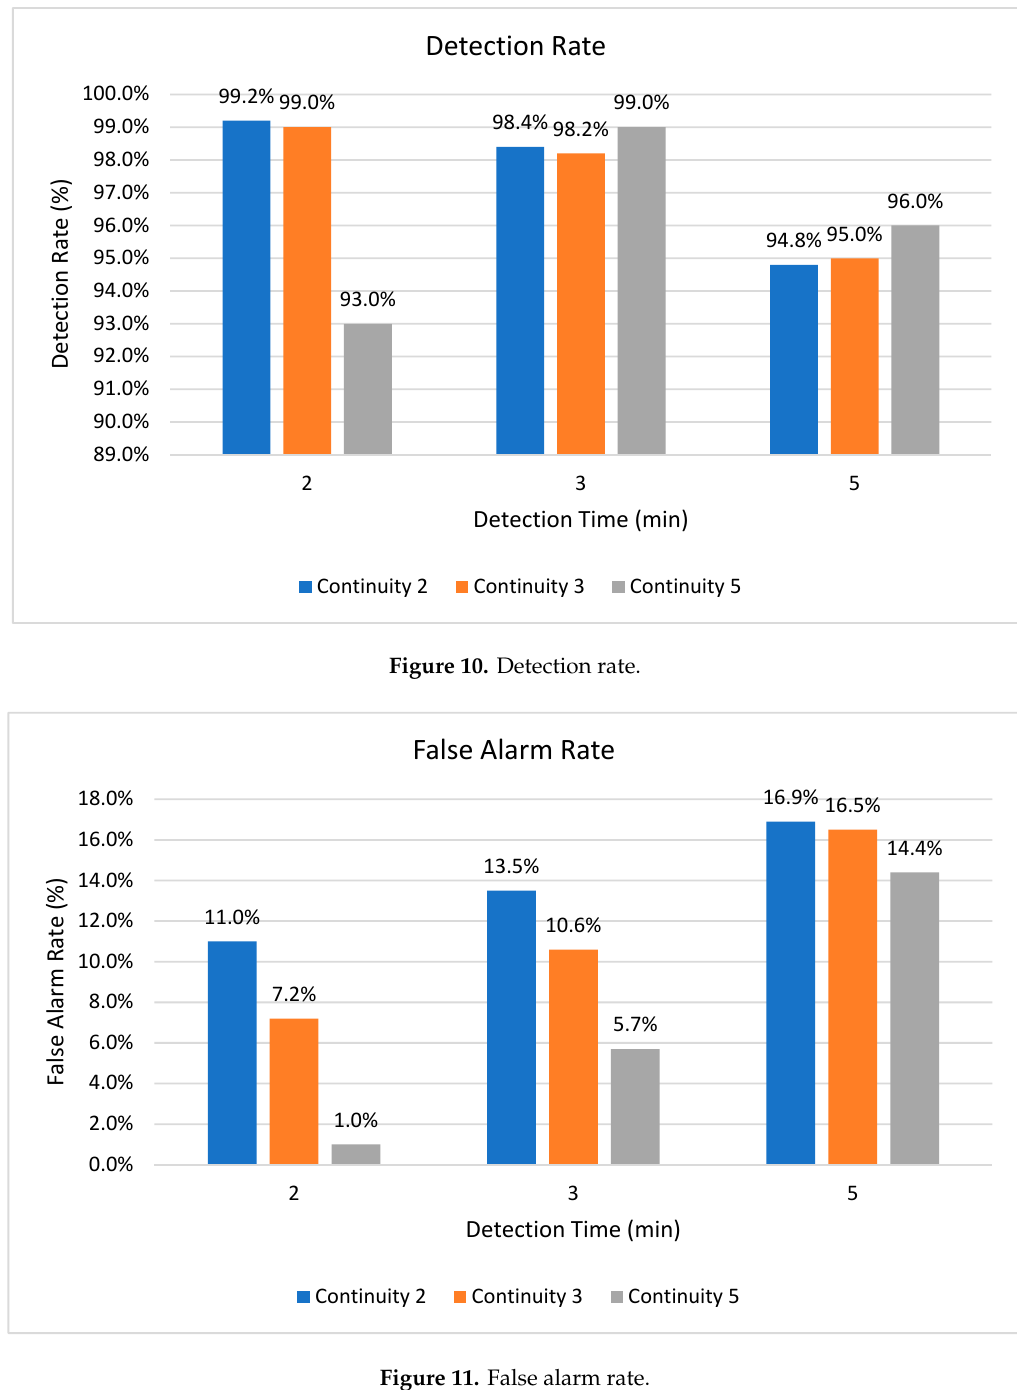
Figure 11. False alarm rate.